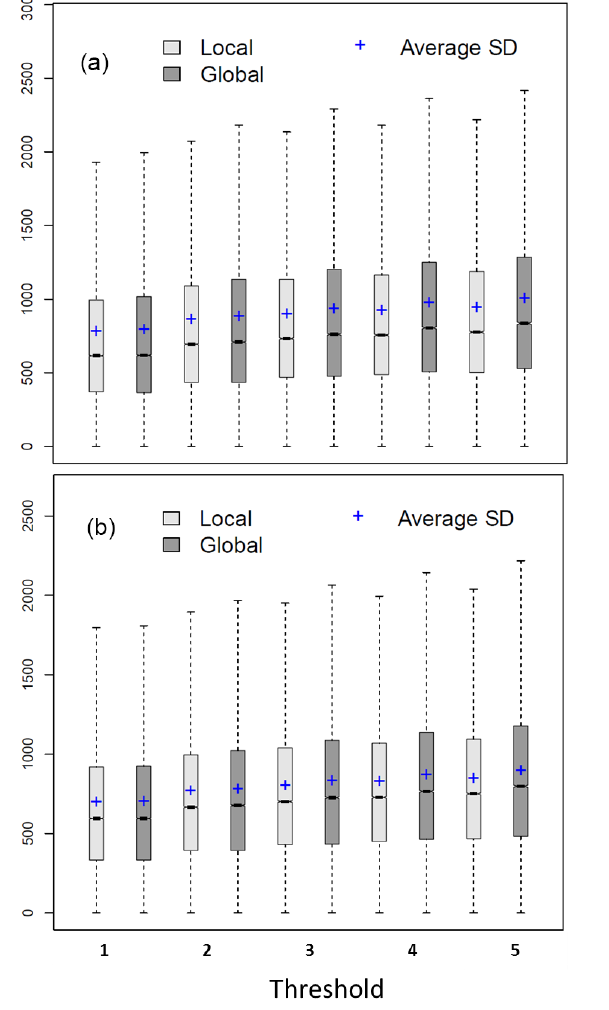
Figure 12. Similar to Fig. 6, but for the capability of the global and local methods to capture land cover variation based on standard deviation values of eMODIS NDVI during spring (a) and summer (b) , within the non-geo-located SUs based on elevation, slope and aspect across different values of area